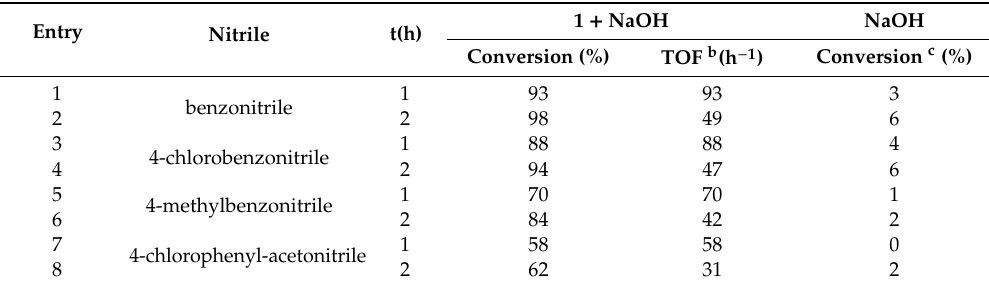
Table 7. Hydration of various nitriles into amides with catalyst 1 with NaOH and catalysis of the same reaction with NaOH only.